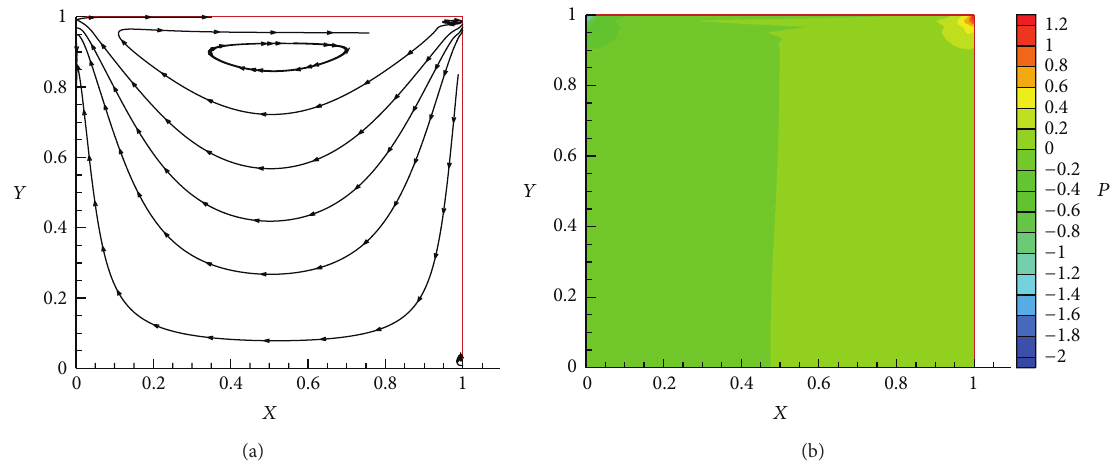
Figure 5: Velocity streamlines (a) and pressure level lines (b) for the local Gauss integration method with the nonconforming element with 𝜀 = 1.0𝑒 − 6 , 𝛼 = 100 , and 𝑟 = 4 , respectively.